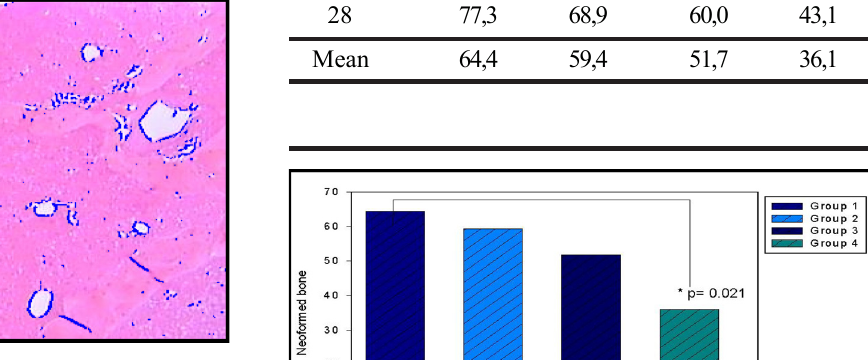
FIGURE 1 - Representation of the histomorphometry process, showing bone neoformation by means of utilizing the Image Pro Plus 4.5 program.